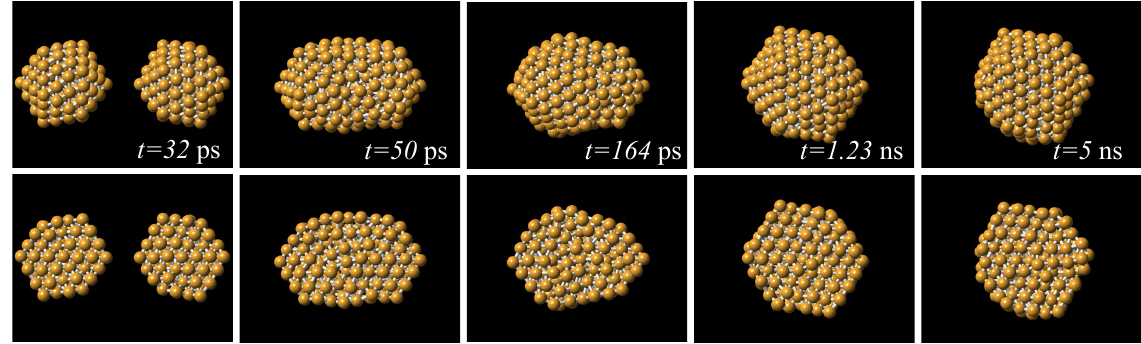
Figure 3. Series of snapshots of the collision between two 147-atom icosahedra. The two particles impact to each other with two of their vertices aligned to the impact direction, and the resulting structure is an I an order larger than the original ones. Upper row: complete h structures; lower row: cross